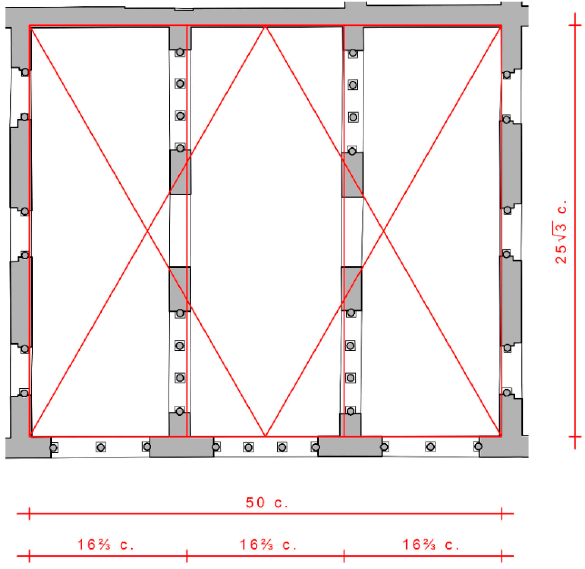
Figure 2. Application of equilateral triangles in the design of the hall of the D ā r al- Ǧ und at Mad ī nat al-Zahr ā ʾ , with measurements in cubits (1 cubit = 46.3 cm). Drawing by Felix Arnold, based on the plan by Ana Zamorano.